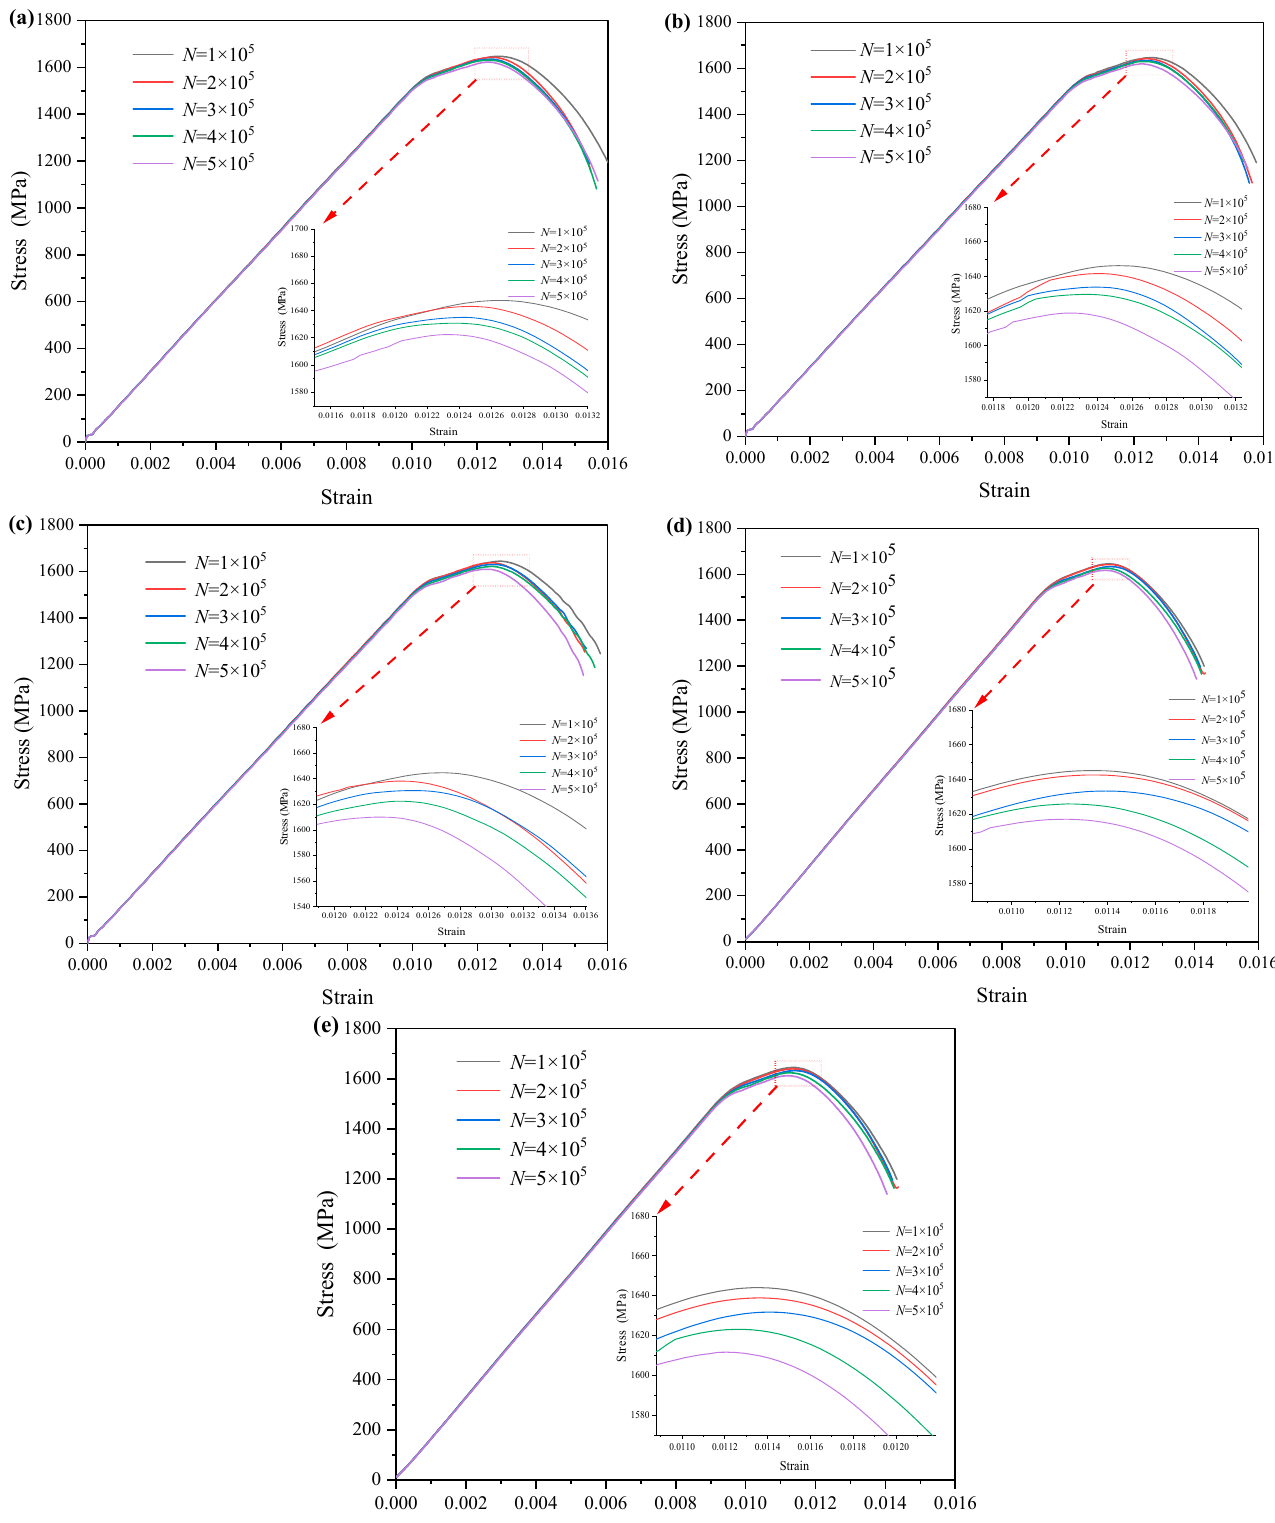
Figure 8. Simulated stress–strain curves of worn wire and saddle groove: ( a ) F n = 60 N and F max = 1000 N; ( b ) F n = 80 N; ( c ) F n = 100 N; ( d ) F max = 1100 N; ( e ) F max = 1200 N.